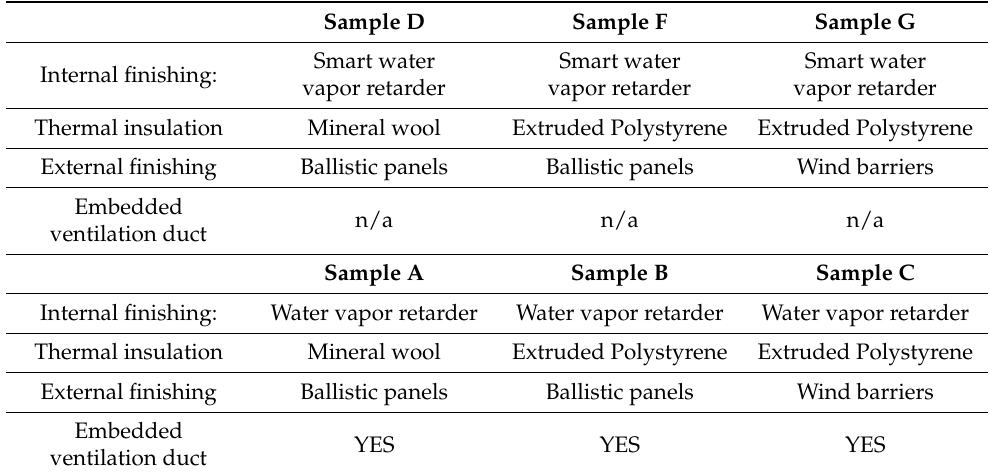
Table 1. Description of